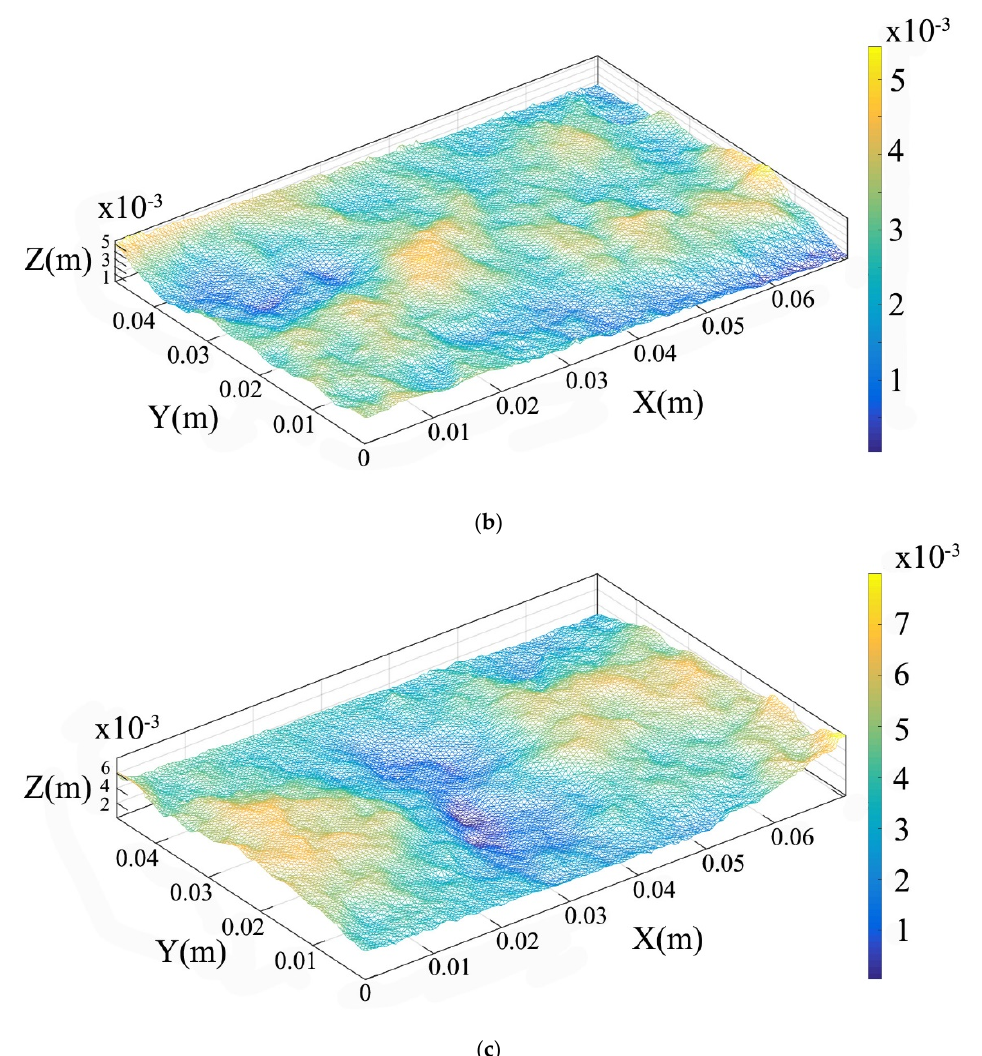
Figure 3. Three dimensional scanning of fracture surfaces: ( a ) G1 (JRC = 13.01), ( b ) G2 (JRC = 13.50), ( c ) G3 (JRC = 13.97).